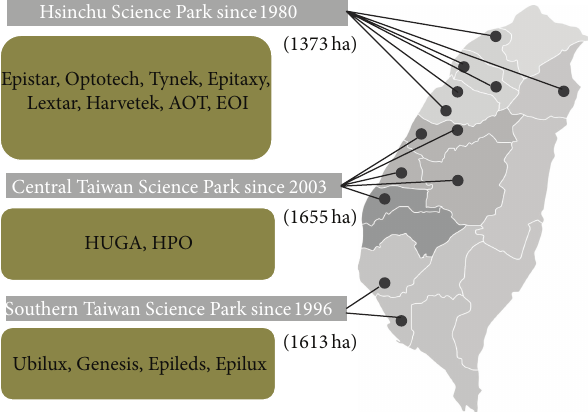
Figure 6: LED firms in Taiwan Science Parks. Source: PIDA (2012) [2].